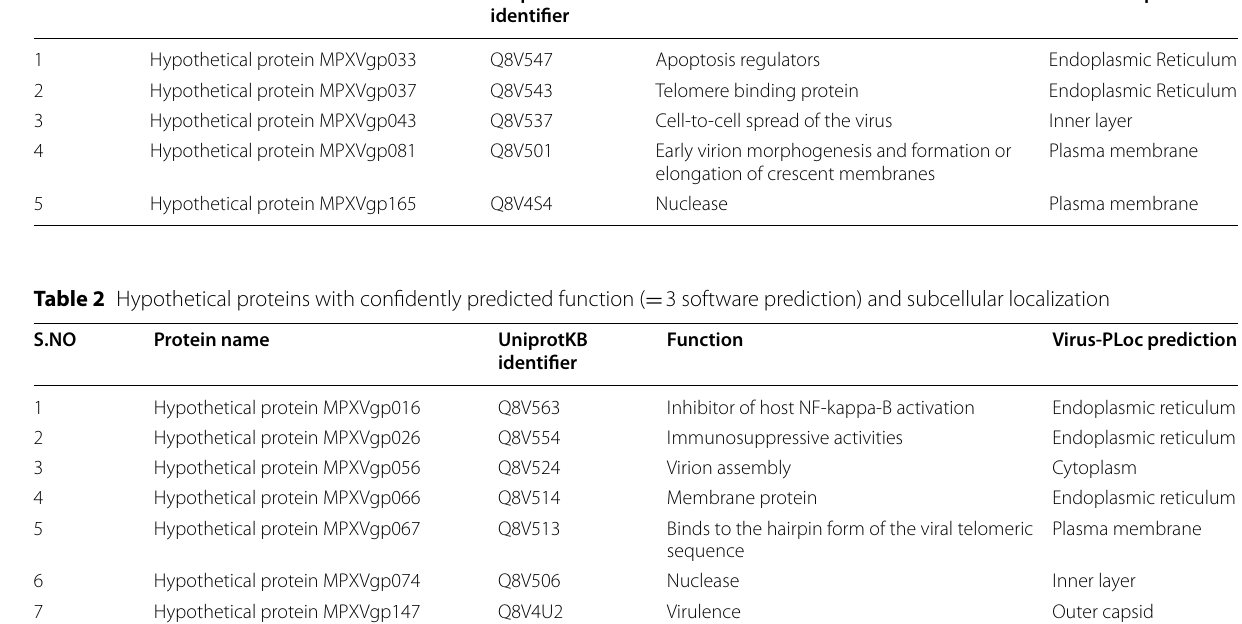
Table 1 Hypothetical proteins with confidently predicted function ( S.NO